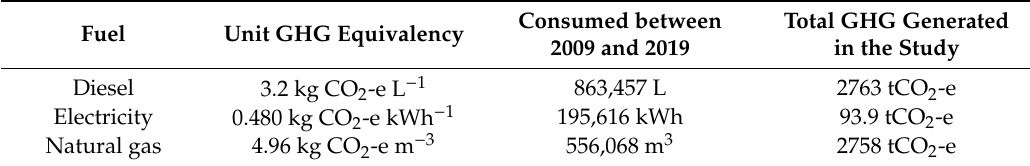
Table 3. The basic data and parameters used in the global greenhouse gas (GHG)